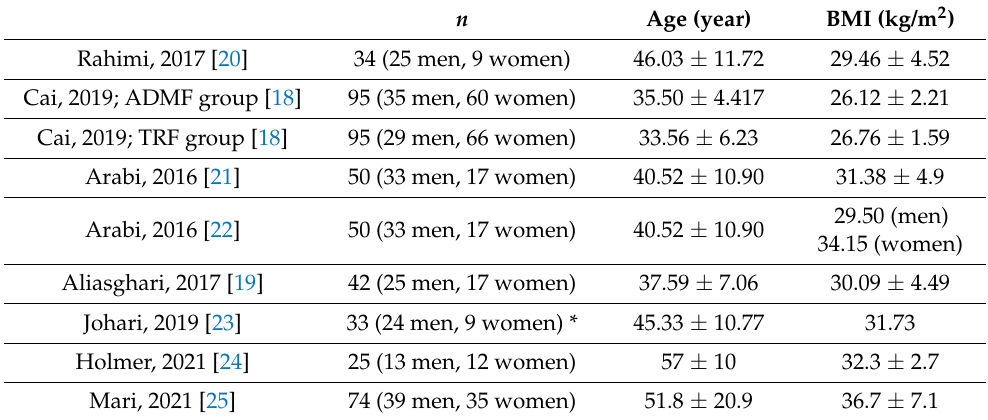
Table 2. Characteristic of studied groups.